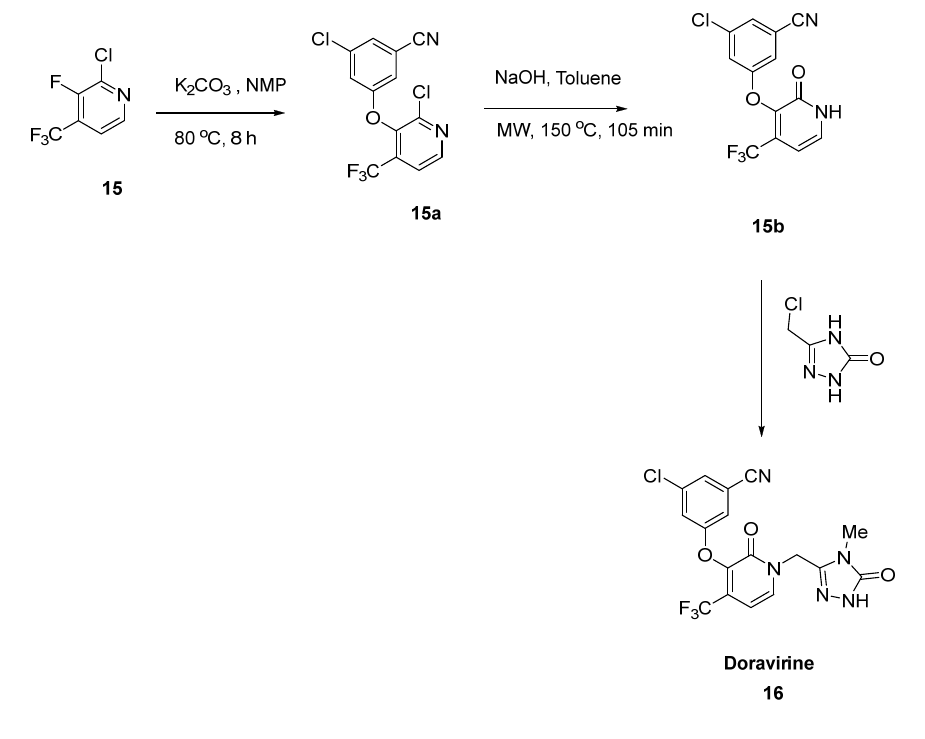
Figure 8. Synthesis and structure of doravirine.